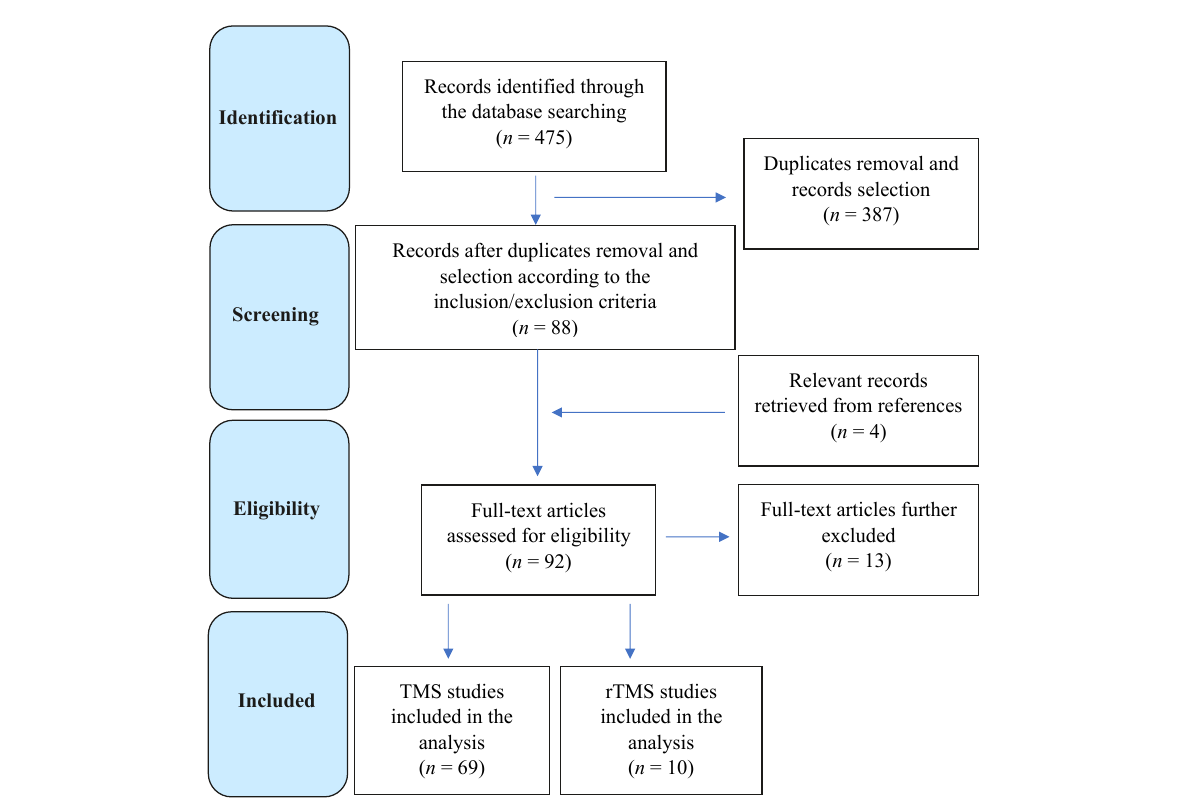
FIGURE1 Flow diagram showing the search strategy, the number of records identified, and the number of included/excluded transcranial magnetic stimulation (TMS) and repetitive TMS studies (Moher et al.,